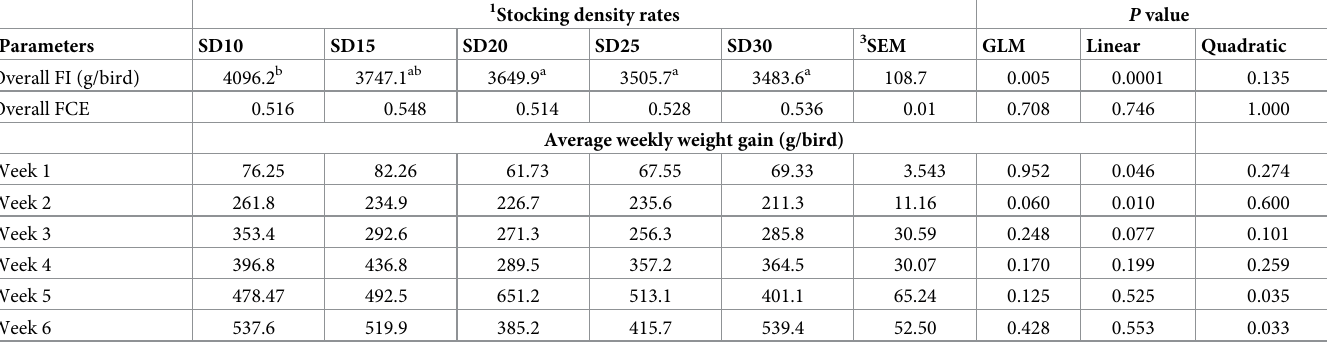
Table 2. The effects of increasing stocking density on growth performance of Ross 308 broiler